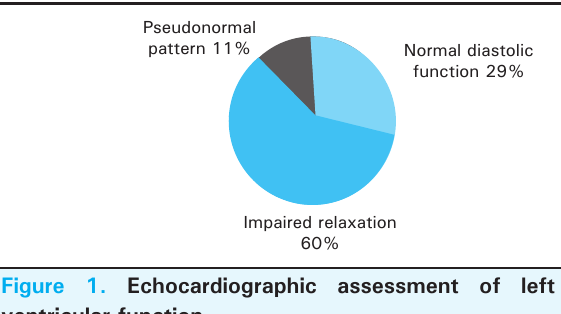
figure 1. echocardiographic assessment of left ventricular